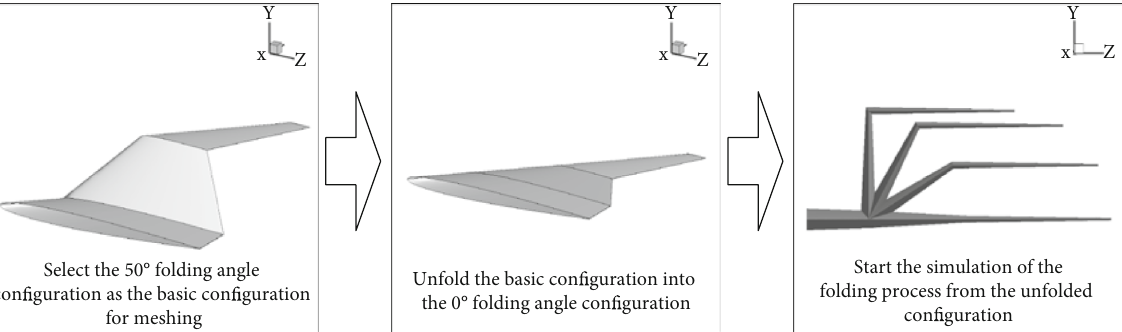
Figure 5: Unfolding – refolding